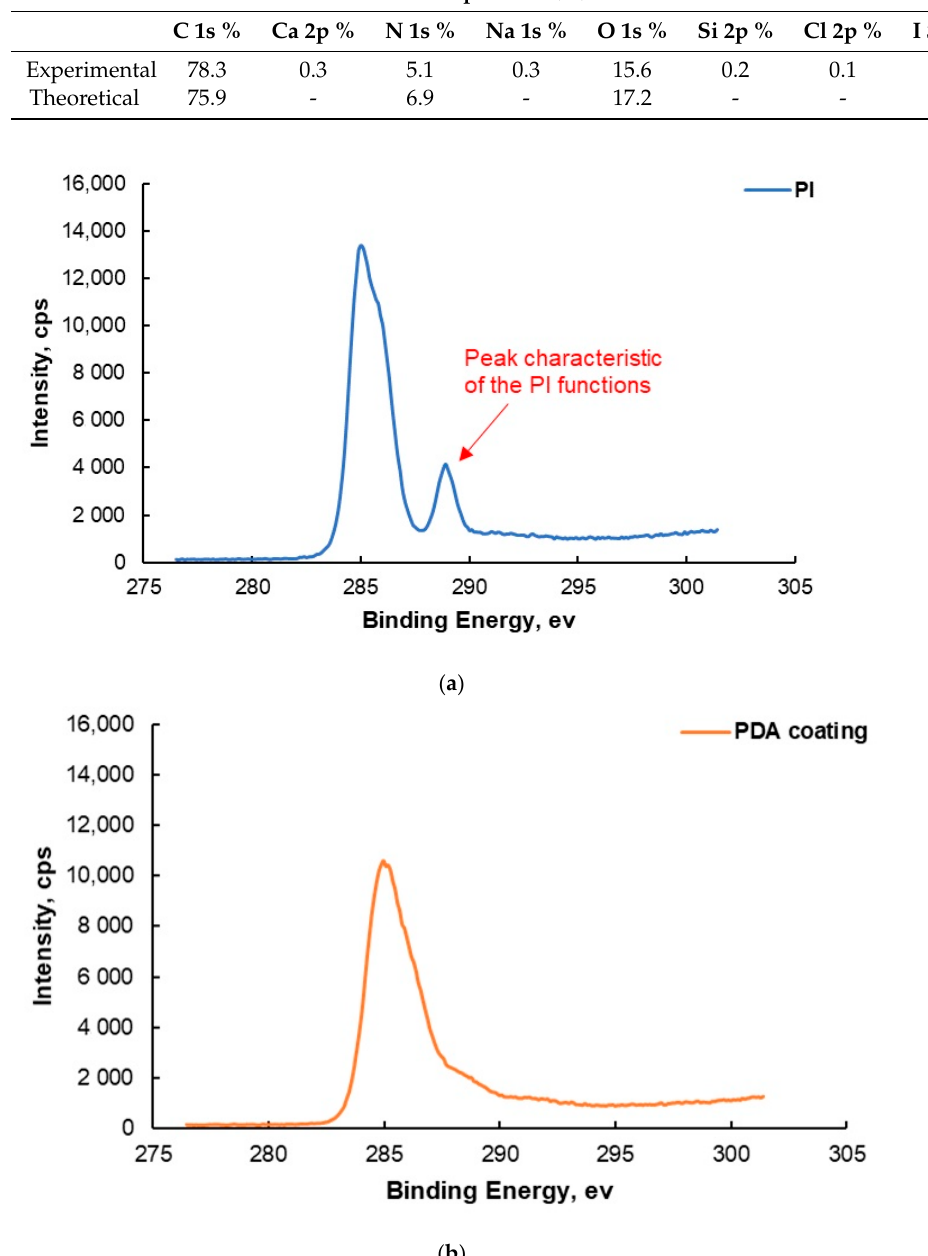
Figure 6. XPS spectra (C 1s high-resolution spectra) of the ( a ) uncoated PI film and ( b ) PDA-coated PI